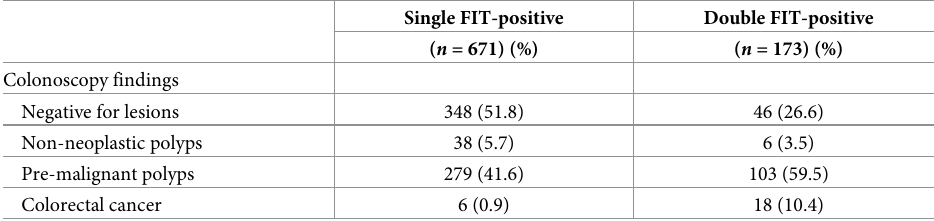
Table 2. Breakdown of findings on follow-up colonoscopy.